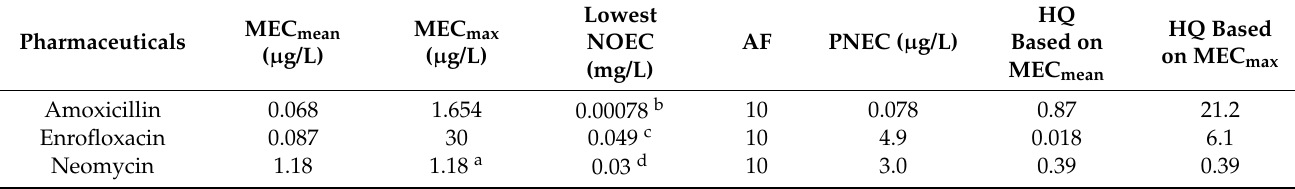
Table 3. Hazard quotients derived for amoxicillin, enrofloxacin, and neomycin.